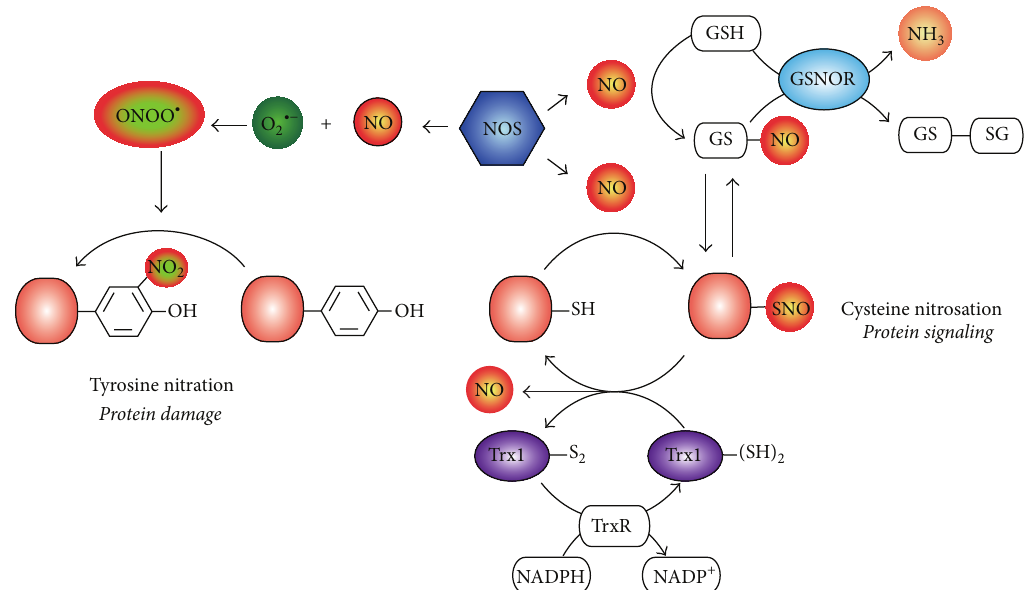
Figure 1: Tyrosine nitration versus S -nitrosation. Nitric oxide (NO), produced by NO synthase (NOS), can affect protein structure and function in different ways. Here only posttranslational modifications directly modifying protein residues are shown, tyrosine nitration (right) and cysteine S -nitrosation (left). The former adduct is irreversible (so far, no denitrating enzyme has ever been found) and responsible for protein damage occurring mostly upon the overproduction of NO. Indeed, under this condition (called nitrosative stress) NO can rapidly react with superoxide anion (O 2∙− ) to form peroxinitrite (ONOO − ) which is the main harmful radical species inducing tyrosine nitration. Conversely, upon physiological production of NO, reactive cysteines of both redox-sensitive proteins and glutathione (GSH) can undergo S -nitrosation, thereby generating their S -nitrosothiol derivatives, Prot-SNOs and S -nitrosoglutathione (GSNO), respectively. Prot-SNOs and GSNO are in equilibrium by transnitrosation reactions; therefore, the GSNO catabolizing enzyme, GSNOR reductase (GSNOR), by regulating GSNO levels also impacts on protein nitrosation extent. Thioredoxin 1 (Trx1) also participates in protein denitrosation by means of its vicinal thiols that reduce Prot-SNO and oxidize to an internal disulfide bridge, whose further reduction is catalyzed by Trx reductase (TrxR) and ensured by reducing equivalents provided by NADPH. Although both GSNOR and Trx1 concur to modulated protein S -nitrosation, it should be reminded that the former enzyme completely reduces GSNO to glutathione disulfide (GSSG) and ammonia (NH 3 ), whereas the latter releases the NO moiety of Prot-SNOs as NO itself or nitroxyl anion (HNO), which are species still capable to target protein